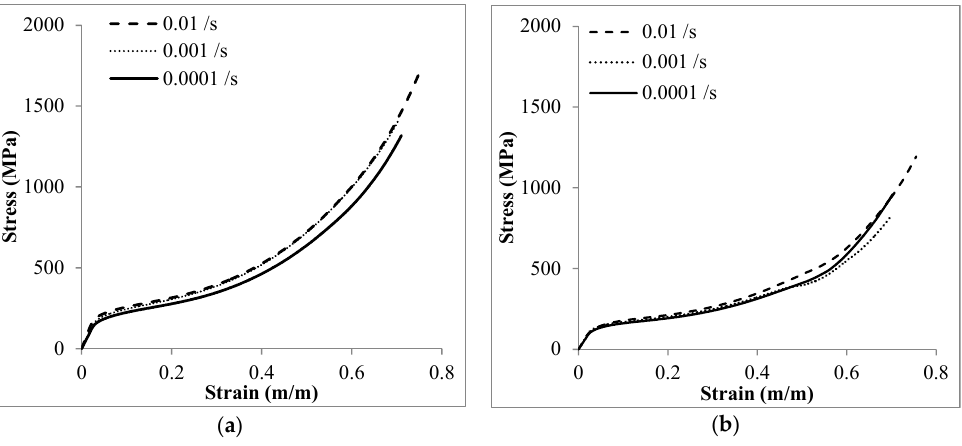
Figure 5. Representative of the compressive stress ‐ strain response of: ( a ) Invar ‐ 5CS; and ( b ) Invar ‐ 10CS at strain rate of 10 − 2 , 10 − 3 and 10 − 4 s − 1 . Table 2. The yield strength, densification strain and energy absorption at 50% strain and densification point of Invar SFs under quasi–static loading.